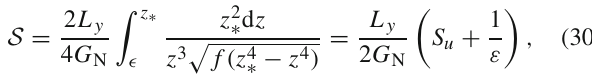
Fig. 3 The HEE ( a ) and the HSC ( b ) as functions of the temperature T / √ ρ = 10. The dashed and solid curves correspond respectively to normal and superconducting phases L x